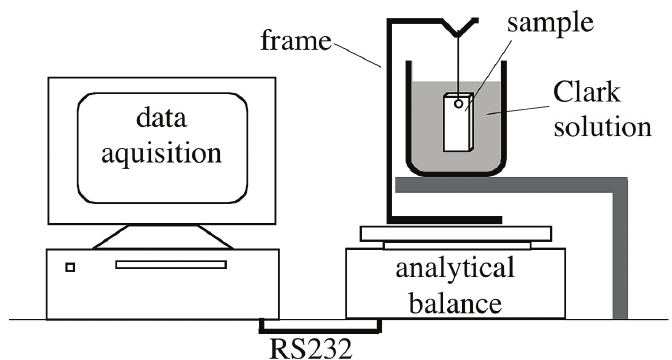
Figure 1. Experimental scheme for in situ weight loss measurements during oxide dissolution of corroded samples in Clark